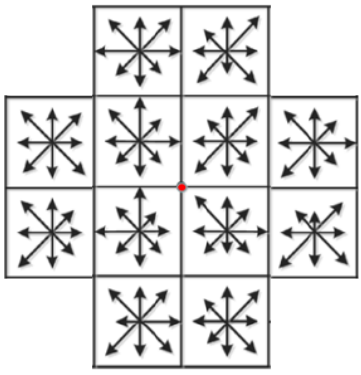
Figure 3. 96-dimensional feature